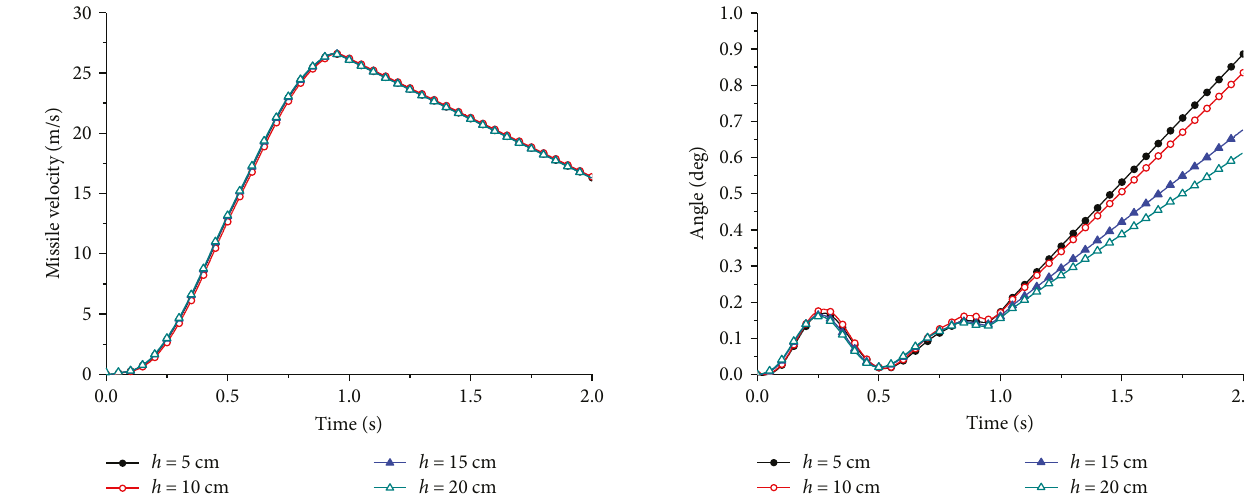
Figure 17: Pitch angle of the missile in di ff erent surface layer thicknesses.